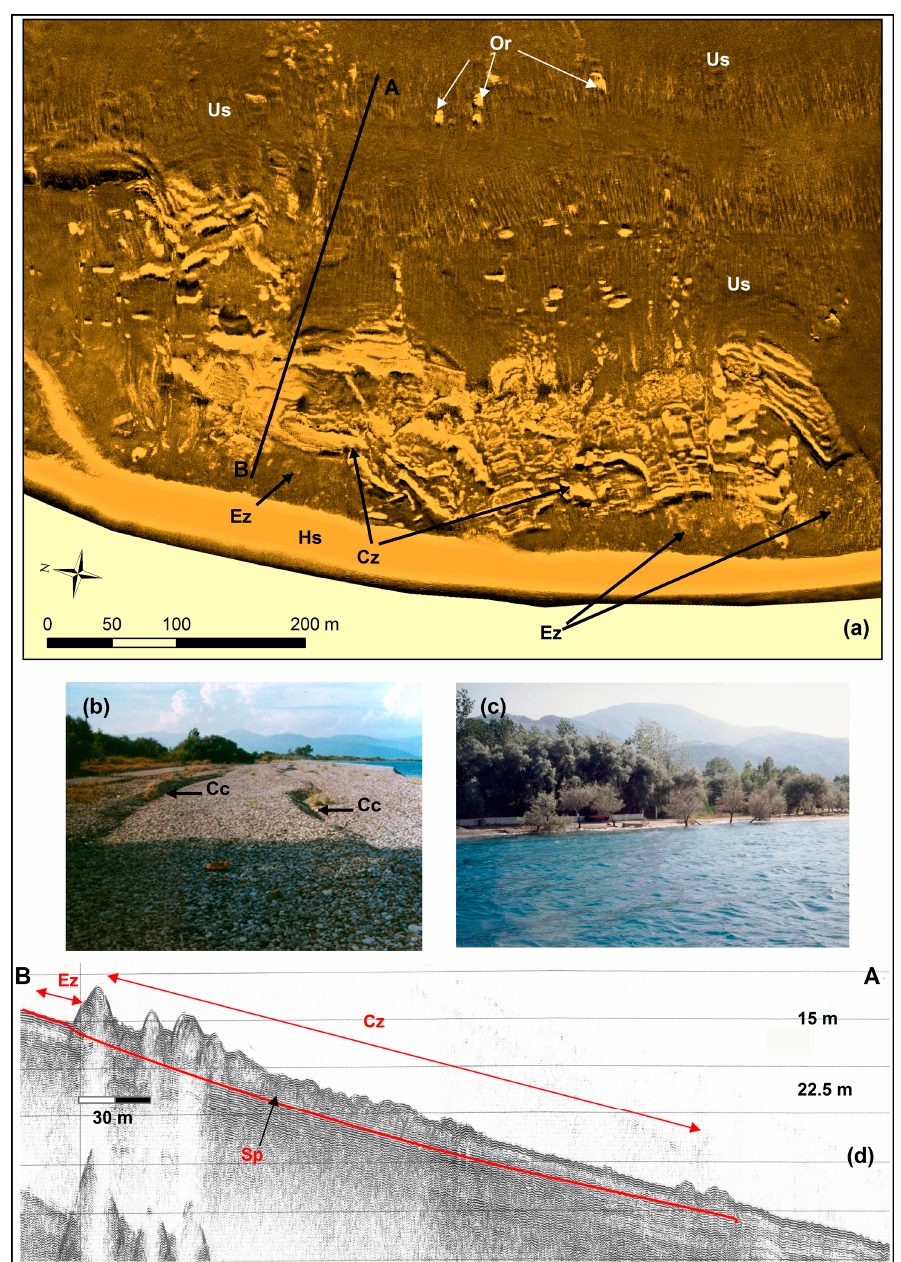
Figure 4. ( a ) Side scan sonar mosaic showing different backscatter acoustic patterns; (Hs): Head scarp, (Ez): Evacuation zone, (Cz): compressional zone, (Or): out-runners, (Us): Undisturbed sediments; ( b , c ) Photographs showing the slide crown and the associated en echelon fault rotated blocks (crown cracks-Cc), which affected the beach, and trees standing in the surf zone indicative for the submerged part of the beach, respectively, and ( d ) seismic profile across the coastal landslide showing (Ez): Evacuation zone, (Cz): compressional zone, (Sp): Slip plane. For the location of the mosaic and the profile see Figure